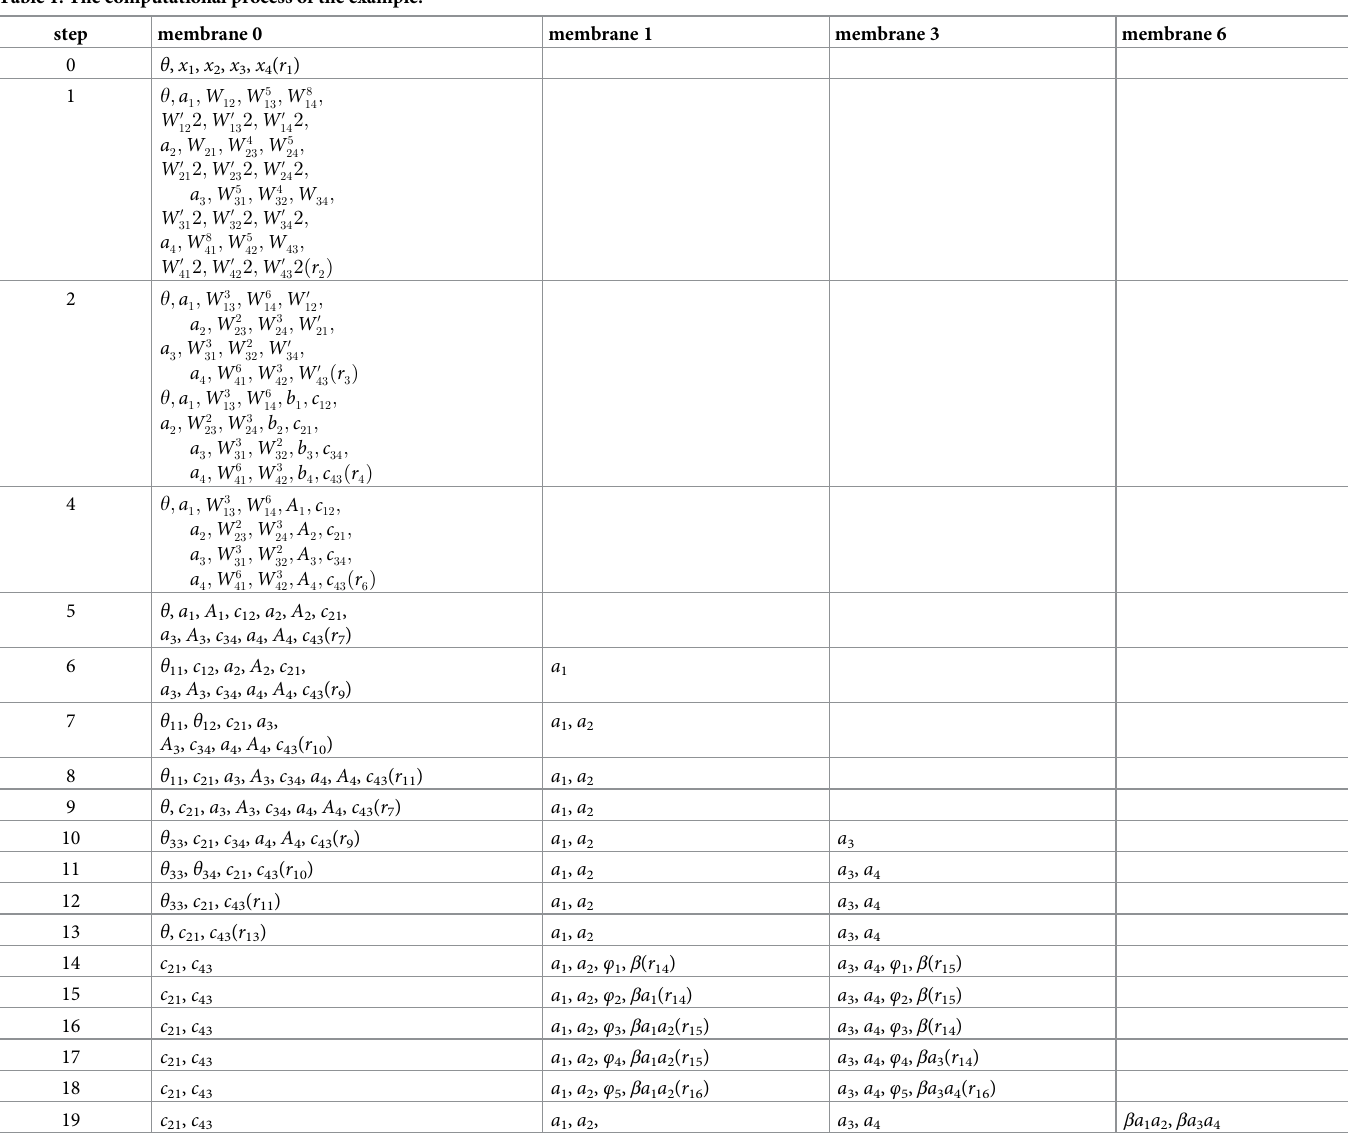
Table 1. The computational process of the